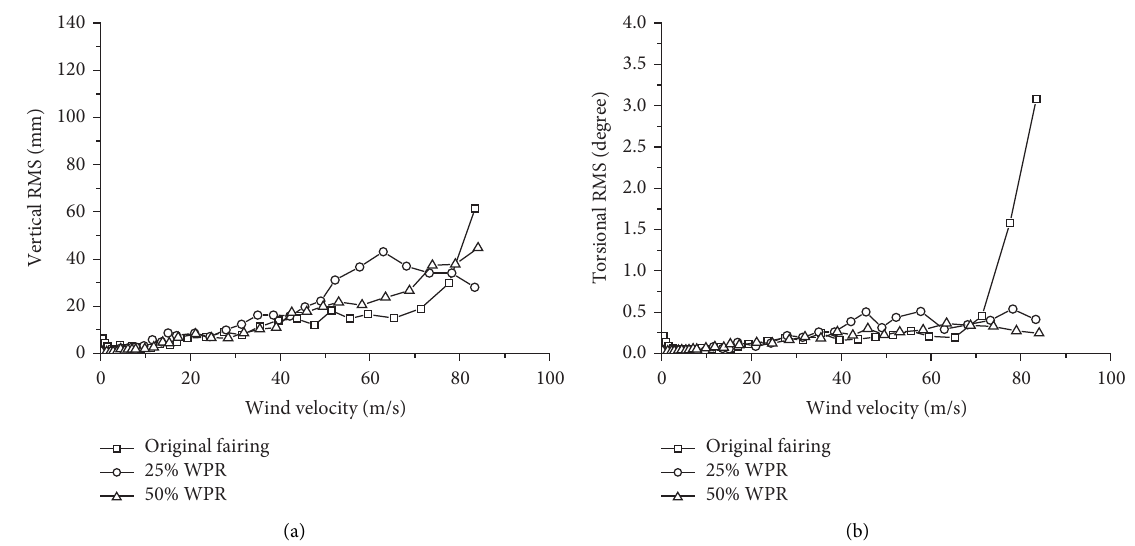
Figure 16: RMS versus wind velocity in turbulent flow (attack angle − 3 ° ): (a) vertical RMS; (b) torsional